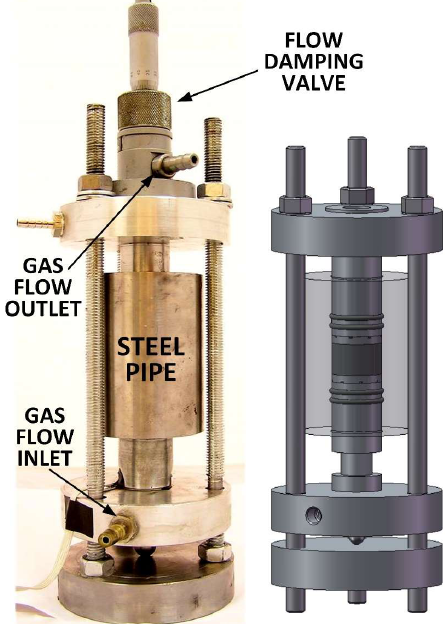
Figure 4. A photograph (left) and 3D model (right) of a part of the measurement stand for investigating coal permeability under stress conditions.